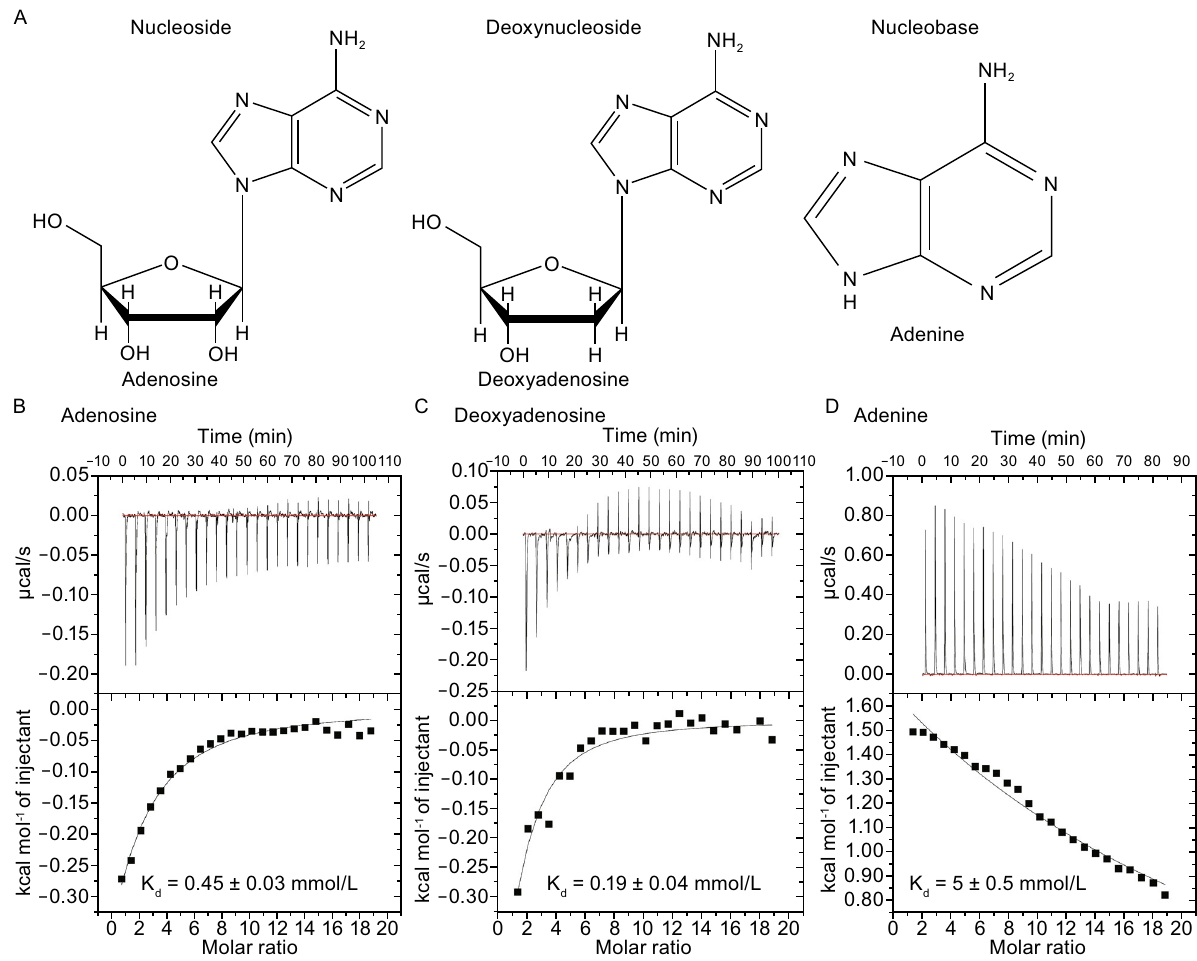
Figure 3. Determination of binding af fi nities between hENT1 and adenosine, deoxyadenosine, or adenine. (A) Chemical structures of adenosine, deoxyadenosine, and adenine. (B) Measurement of the binding af fi nity between hENT1 and adenosine by ITC. Curve fi tting revealed a dissociation constant of 0.45 ± 0.03 mmol/L. The curve was fi tted by Origin 7. (C) Measurement of the binding af fi nity between hENT1 and deoxyadenosine by ITC. (D) Measurement of the binding af fi nity between hENT1 and adenine by